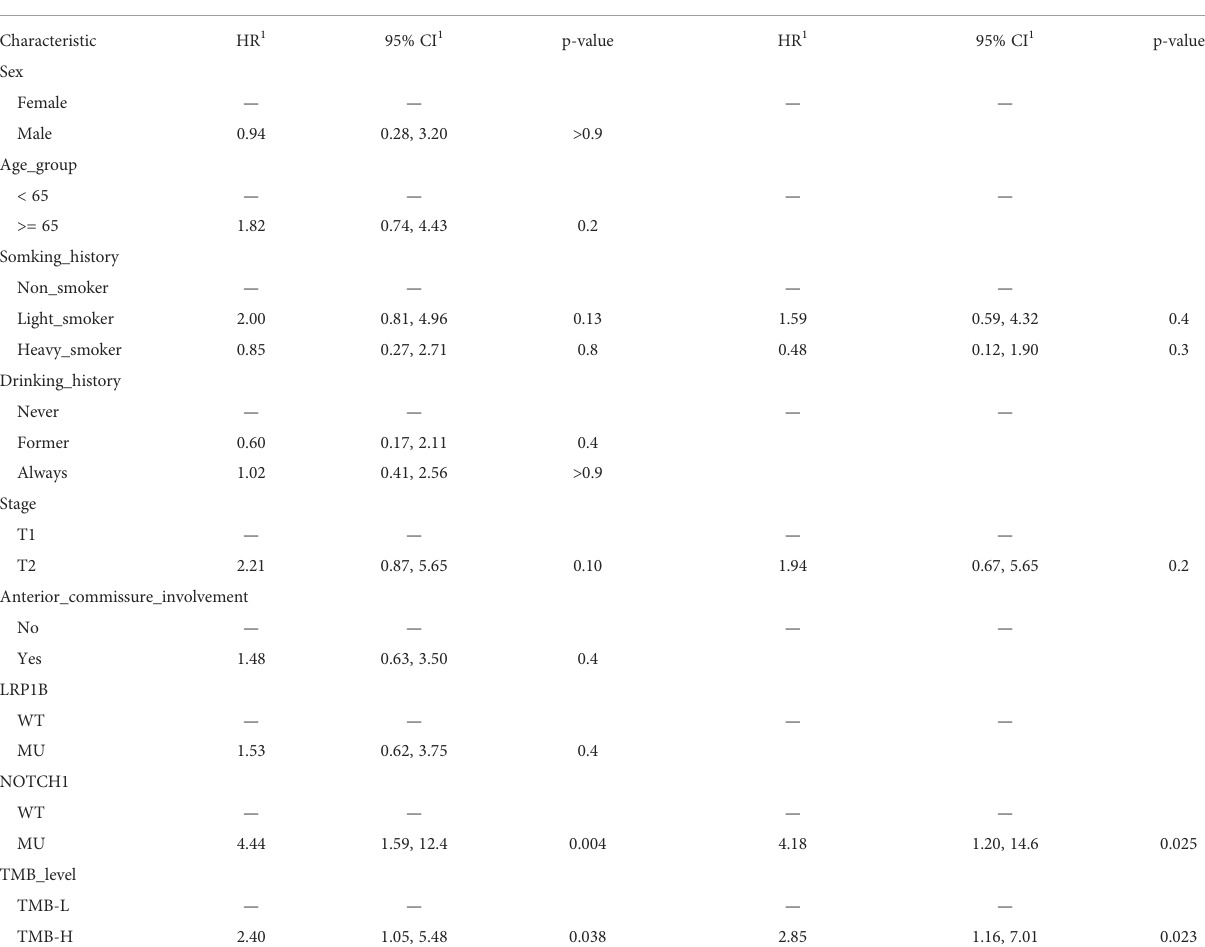
TABLE 2 The results of univariate and multivariate analysis on NOTCH1 mutation with